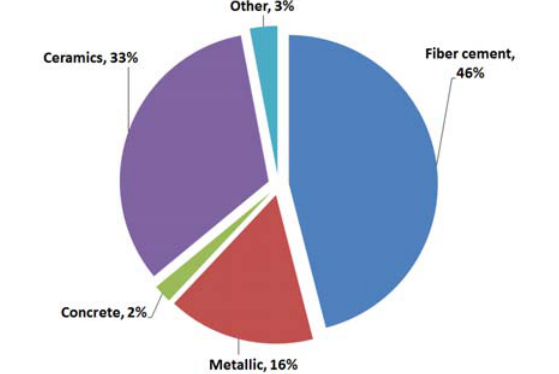
Figure 1. Various types of materials used for popular solutions of roofing in Brazil (Based on